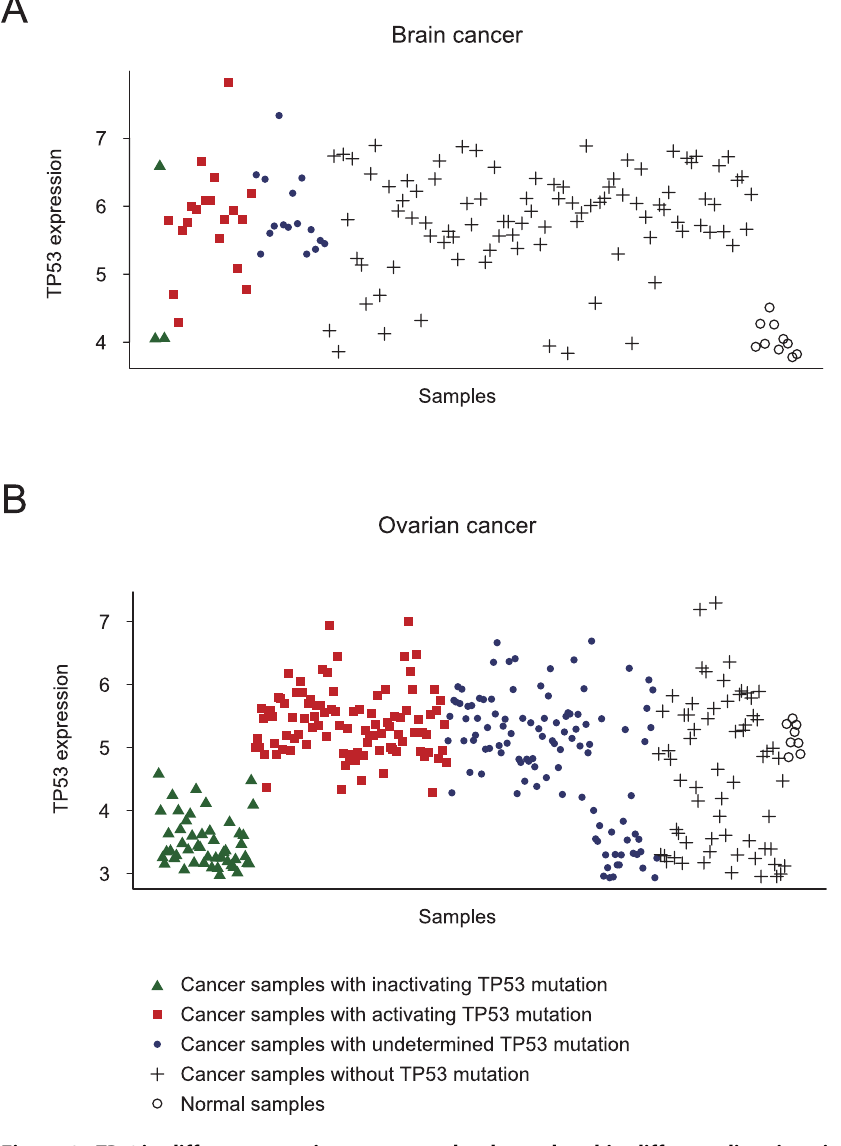
Figure 3. TP53 in different mutation states can be deregulated in different directions in a cancer type. A , In the ovarian cancer, TP53 with activating mutations was up-regulated, whereas both inactivated TP53 and wild-type TP53 were down-regulated; B , In the brain cancer, TP53 with the activating mutations and the wild-type TP53 were up-regulated, whereas TP53 with inactivating mutations were not found to be significantly changed possibly due to the small sample size.